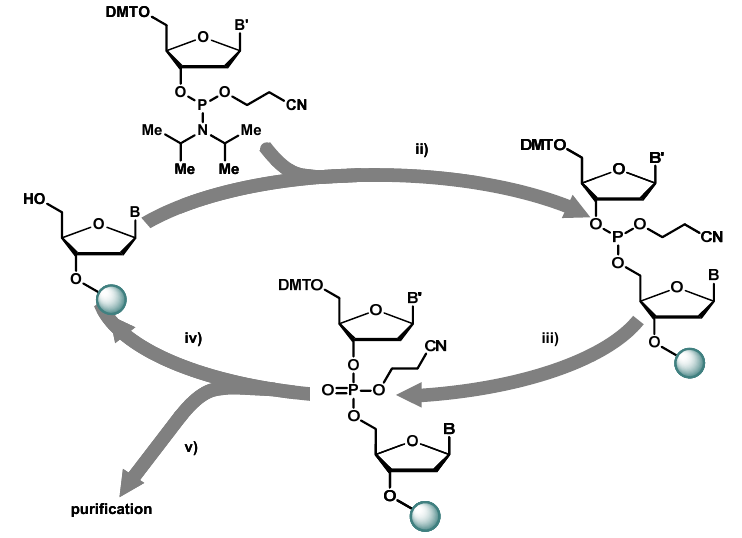
Figure 1. Solid phase oligonucleotide synthesis cycle. DMT = 4,4’-dimethoxytrityl; B,B’ = protected nucleobase. Key: (i) activation (e.g., with tetrazole); (ii)